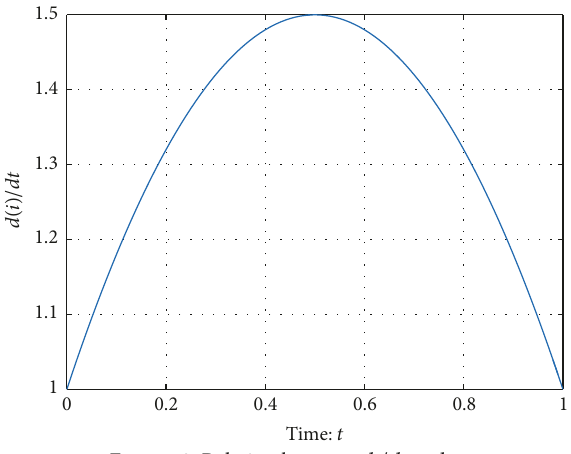
Figure 3: Relation between 𝑑 𝑖 /𝑑 𝑡 and 𝑡 .